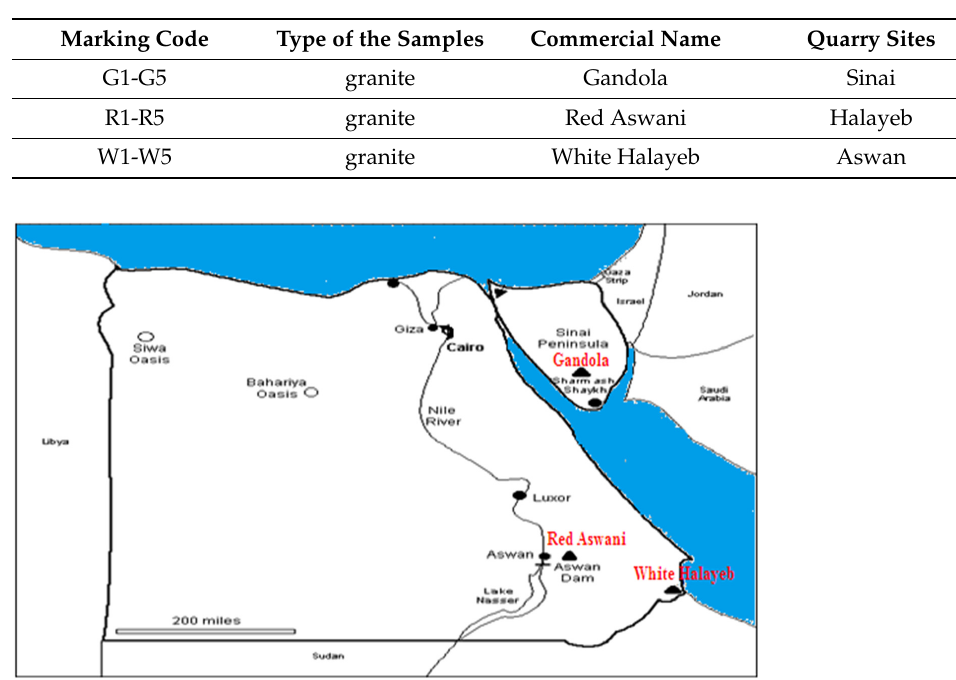
Table 1. Sample markings, descriptions, and locations.